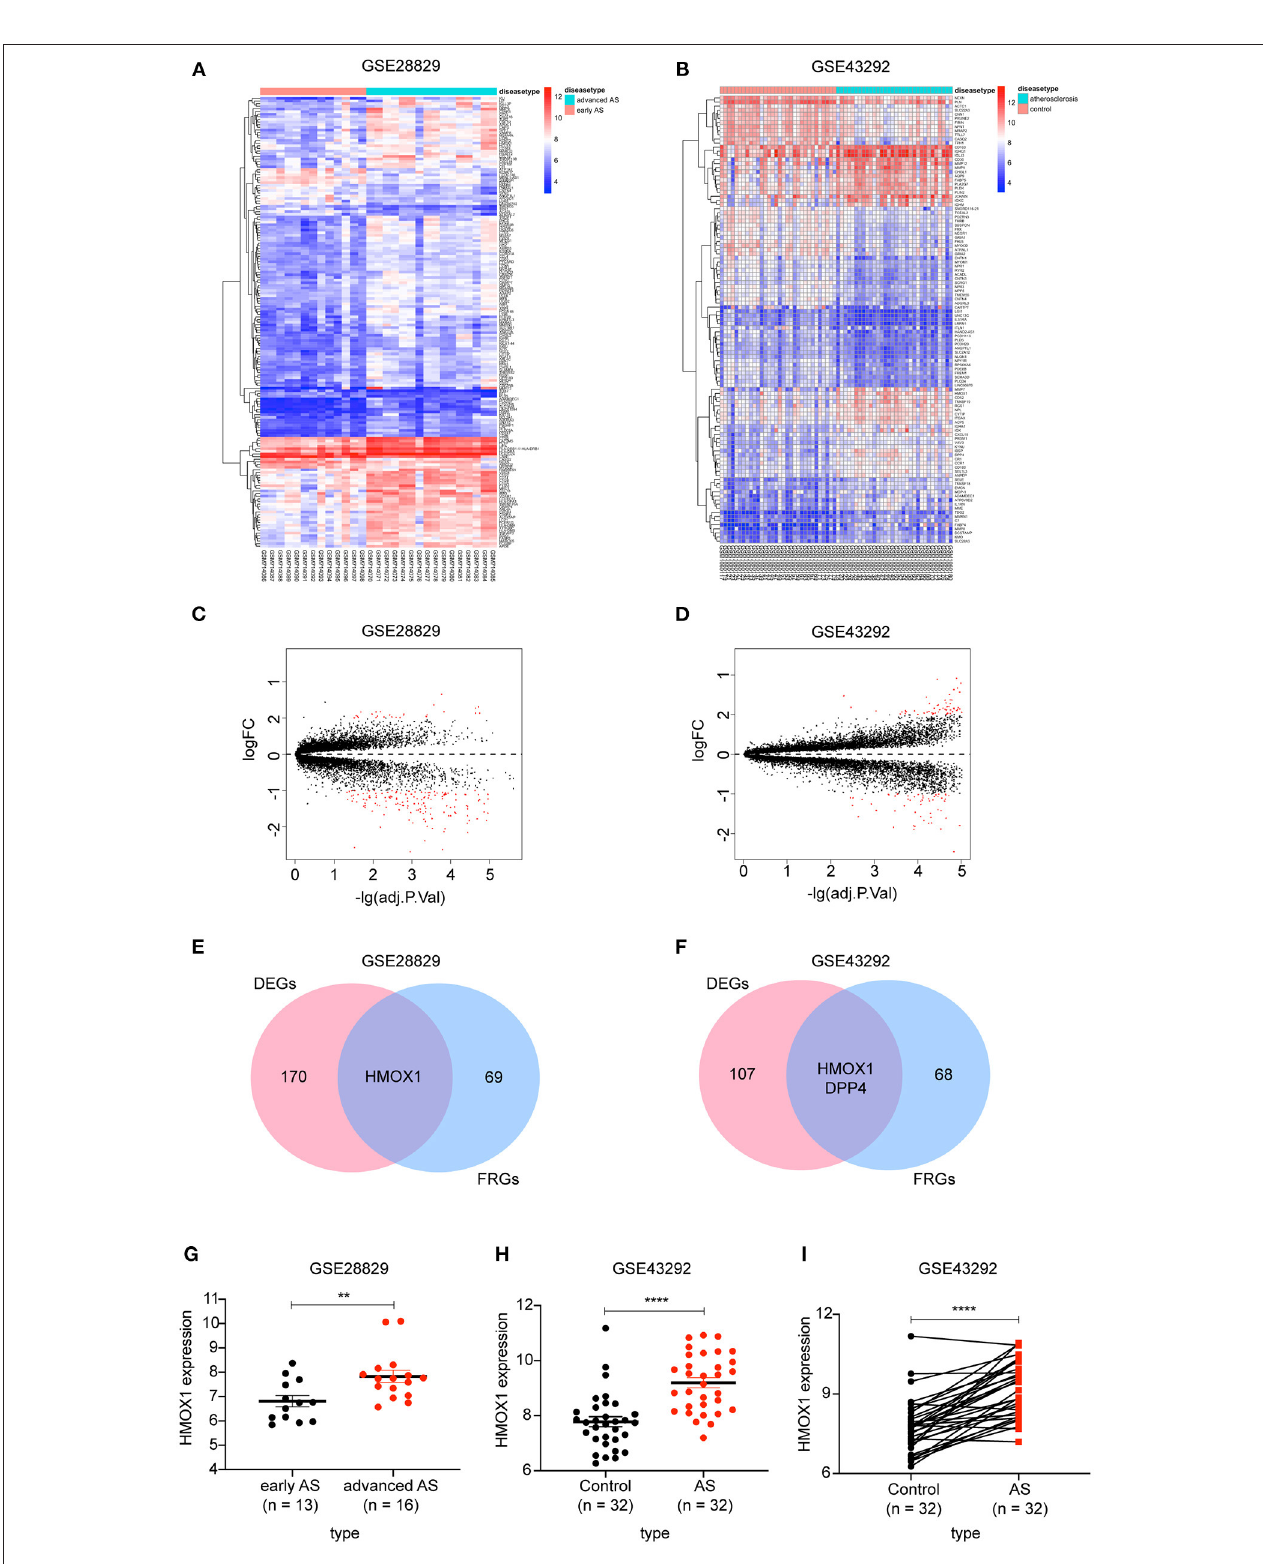
FIGURE 2 | Identification of differential FRGs associated with atherosclerosis. Heatmaps showing DEGs in advanced atherosclerosis compared to early atherosclerosis in GSE28829 (A) and DEGs in atherosclerosis samples compared to samples of distant macroscopically intact tissue in GSE43292 (B) . Volcano plots of DEGs in GSE28829 (C) and GSE43292 (D) . Venn diagram showing that HMOX1 was the only FRG related to atherosclerosis resulting from the analysis of both GSE28829 (E) and GSE43292 (F) databases. The HMOX1 expression level in atherosclerotic plaques compared between paired and non-paired samples in GSE28829 (G) and GSE43292 (H,I) . (** p < 0.01, **** p < 0.0001, compared between the groups by t -test) (FRG, ferroptosis-related gene).